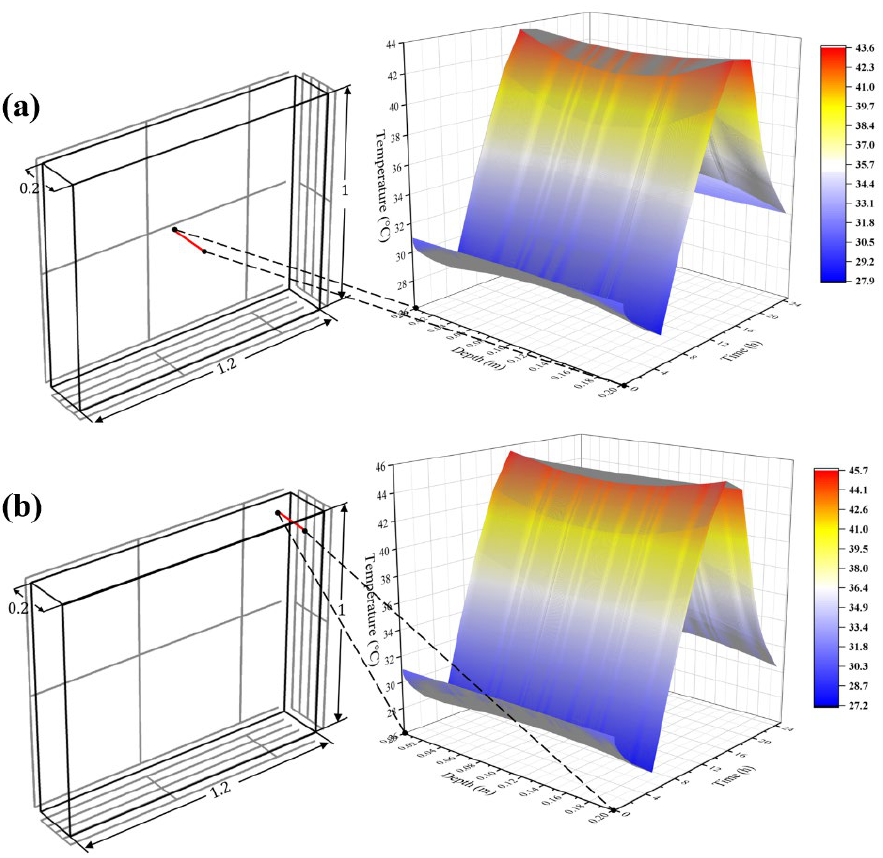
Figure 7. Cloud diagram of concrete internal temperature distribution based on the time-varying